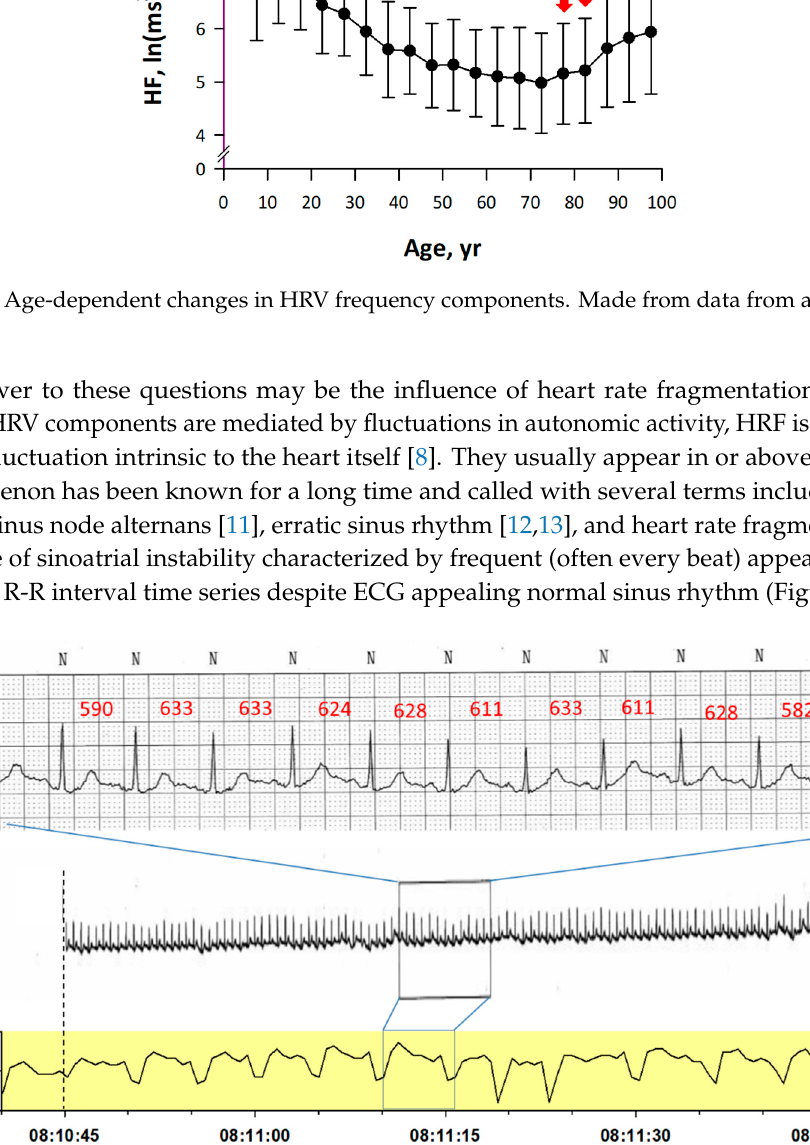
Figure 4. ECG and R-R intervals showing heart rate fragmentation (HRF). Although ECGs look like sinus rhythm (upper and middle panels), R-R interval trend gram shows periodic dip (lower panel).